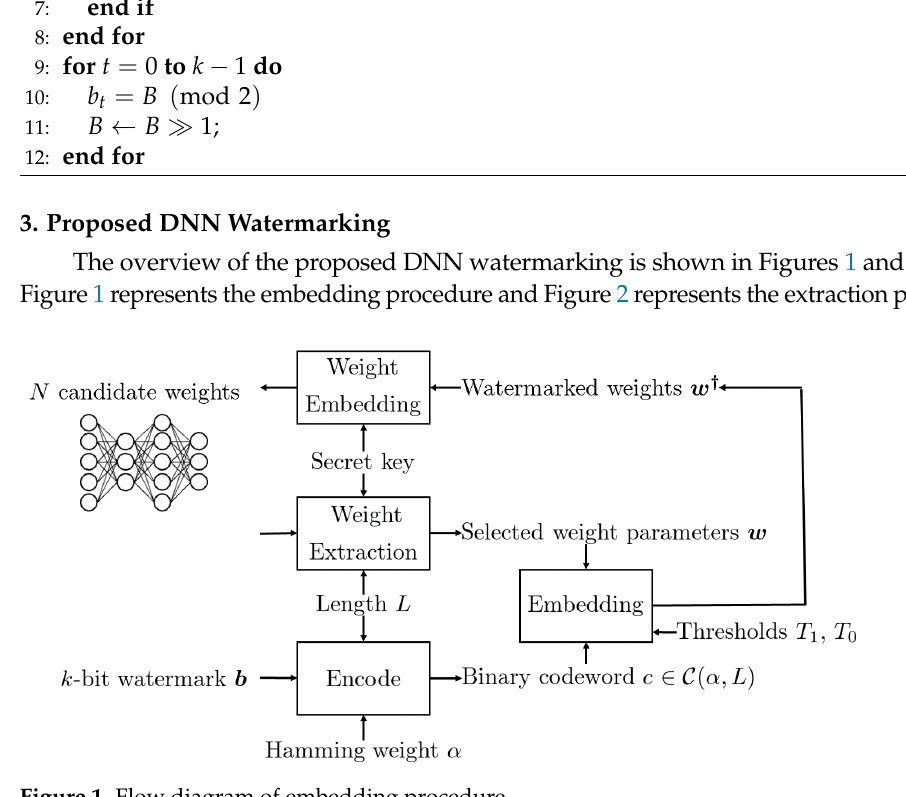
Figure 1. Flow diagram of embedding procedure.